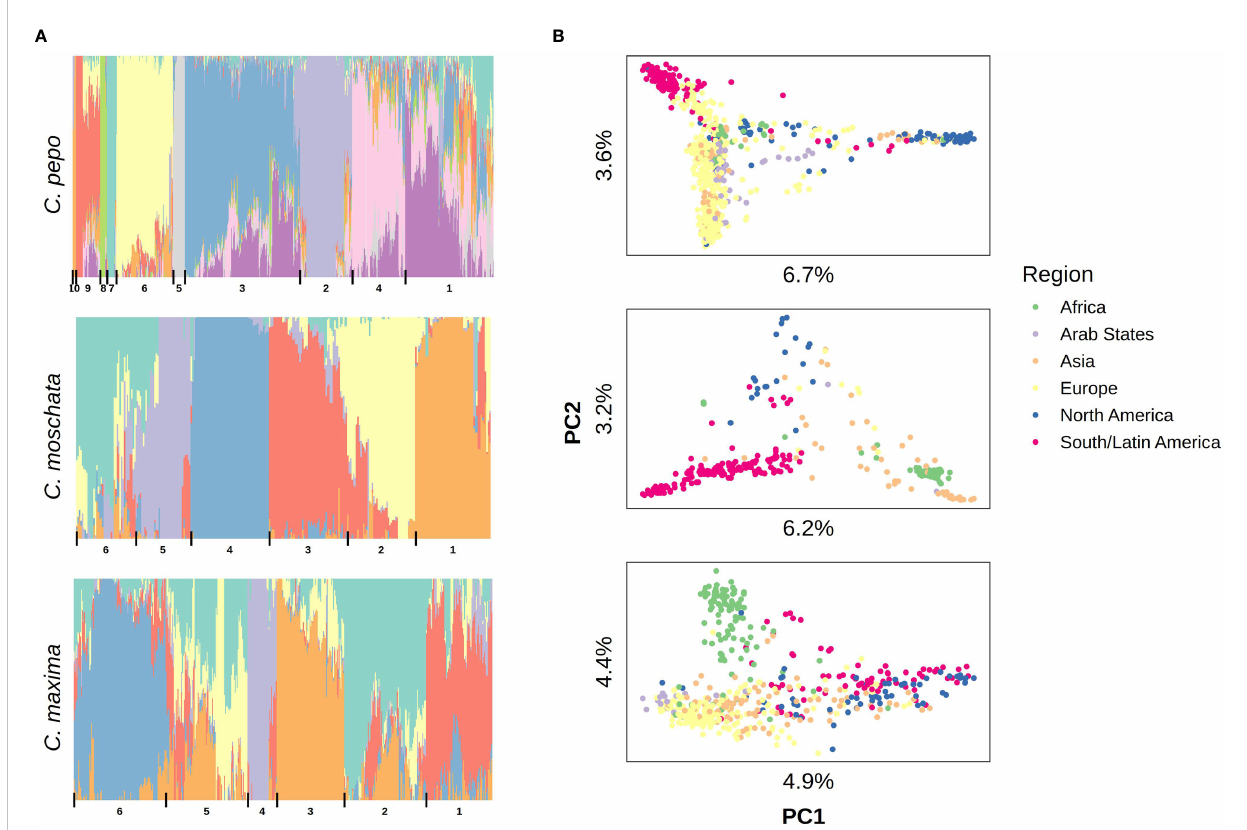
FIGURE 2 Population structure results aligned vertically by species. (A) Admixture plots: each stacked barplot represents an accession colored by proportion of inferred ancestral population. Groups based on hierarchical clustering are delimited by vertical bars and labeled with numbers along the bottom. (B) Plots of the fi rst two principal components (PC) of accessions colored by region, variation explained by PCs is labeled on each